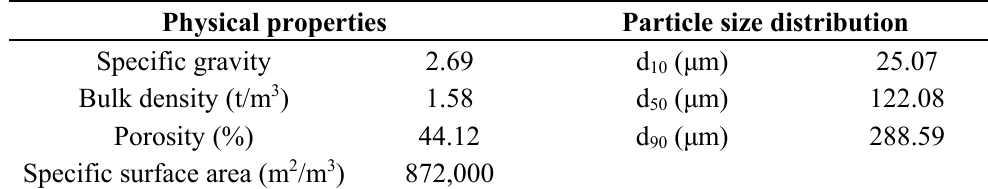
Table 1. Physical properties and particle size distribution of